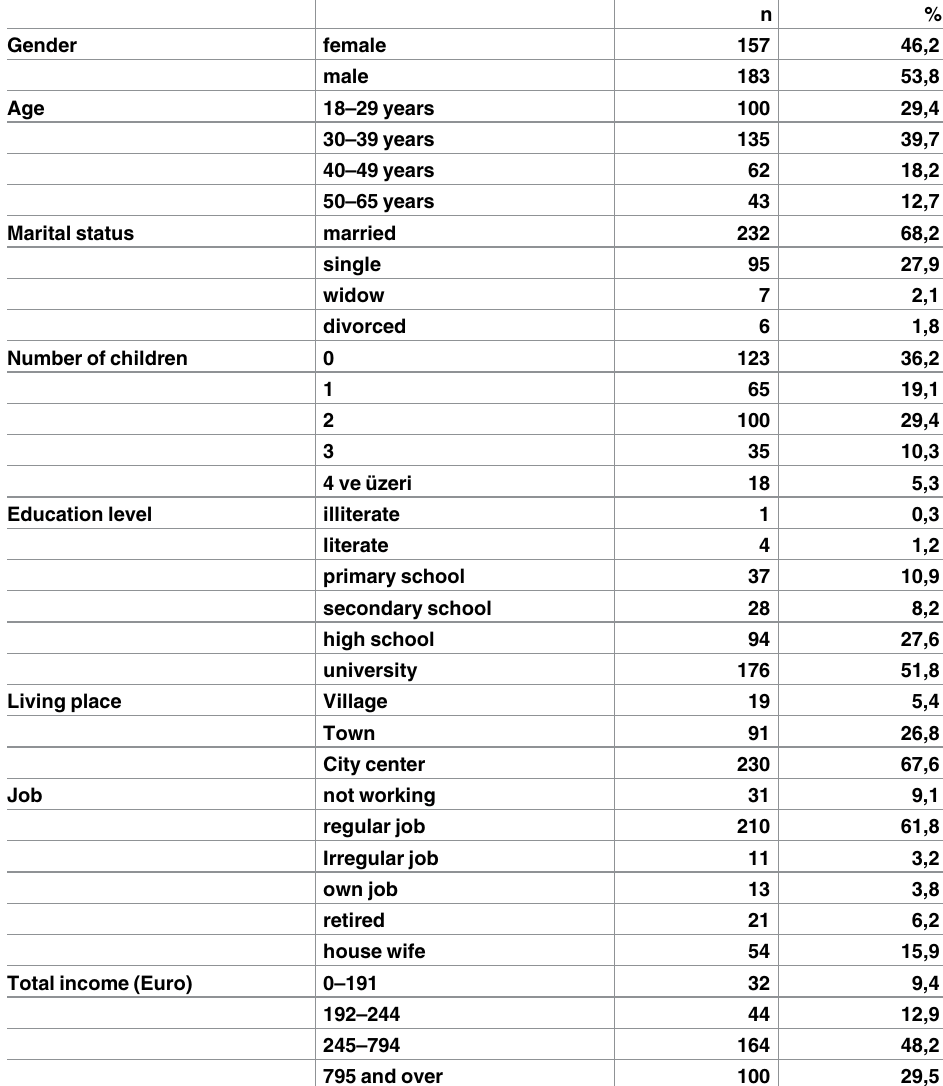
Table 1. Sociodemographic